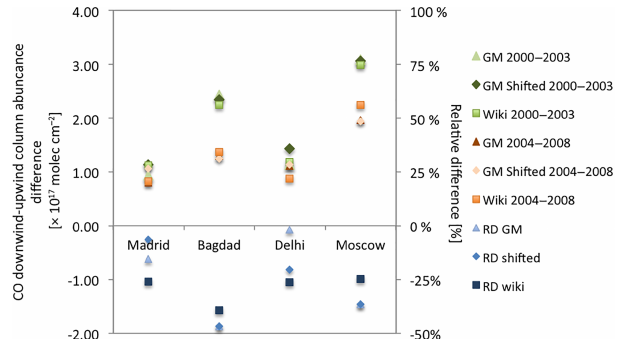
Figure 8. Upwind–downwind difference (left axis, orange, green) and RD calculation (right axis, blue points) for Madrid, Baghdad, Delhi and Moscow using different rotation points within the city center. GM: Google Maps location of the center; GM shifted: 5km shift of this point to another center location; Wiki: Wikipedia loca- tion of the center. Wikipedia center points are off by 3.9, 3.1, 2.1 and 0.7km from the GM center points for Madrid, Baghdad, Delhi and Moscow,